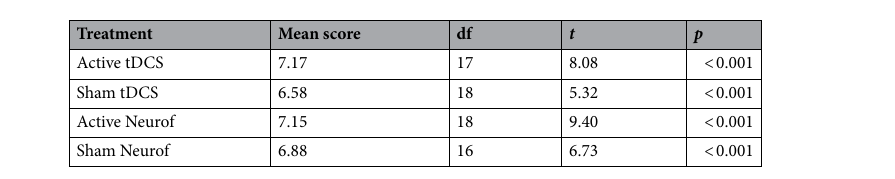
Table 1. Results for one-sample t-tests against 5 for each treatment group, with mean score, degrees of freedom (df), t -value and p -value.